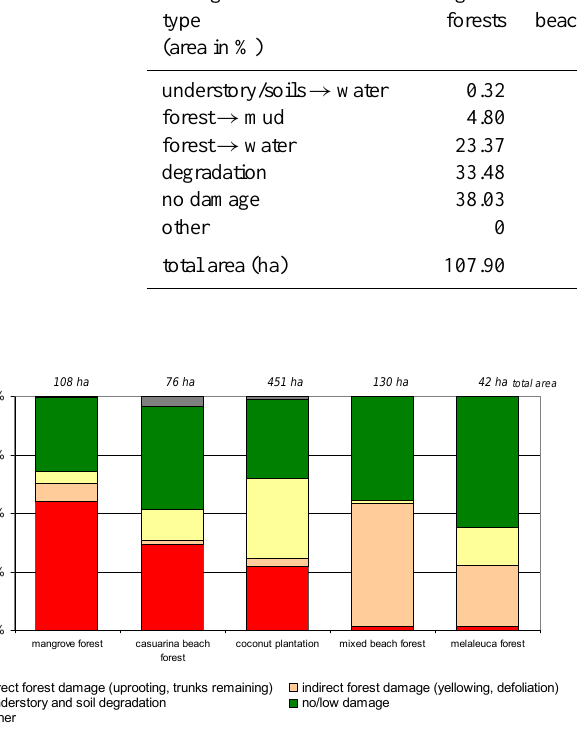
Table 5. Damage statistics (area in %) based on DMC.